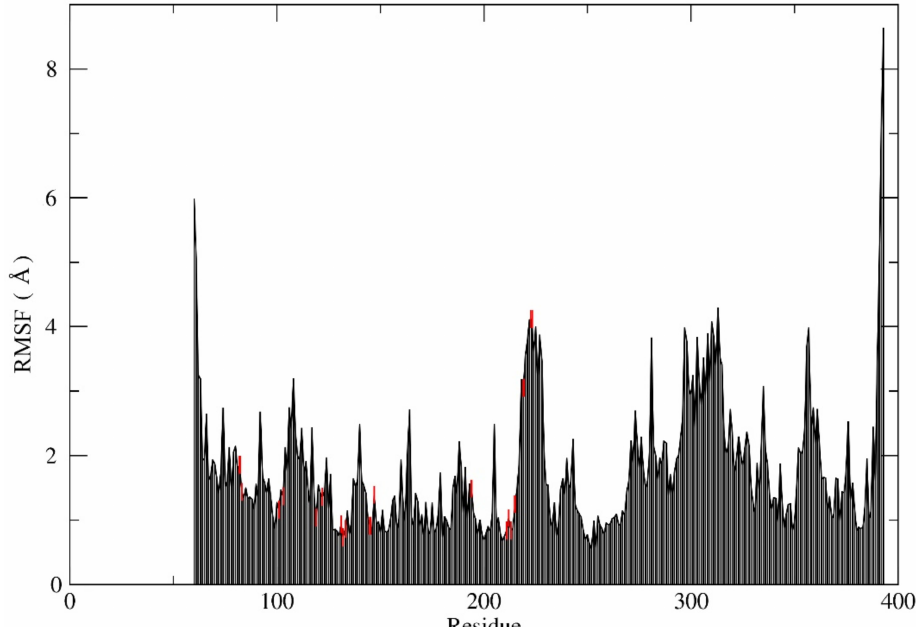
Figure 8. Root-mean-square fluctuations (RMSF) confirmations of protein-ligand complexes, with interacting residues in